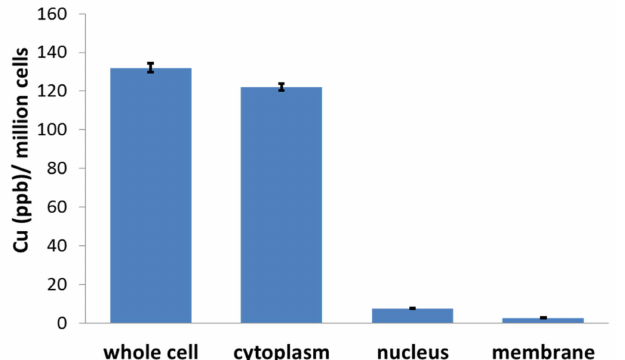
Figure 4. Copper content in whole cell, cytoplasm, nucleus and membrane fractions isolated from HMLER-shEcad cells treated with 2 (1 µ M for 16